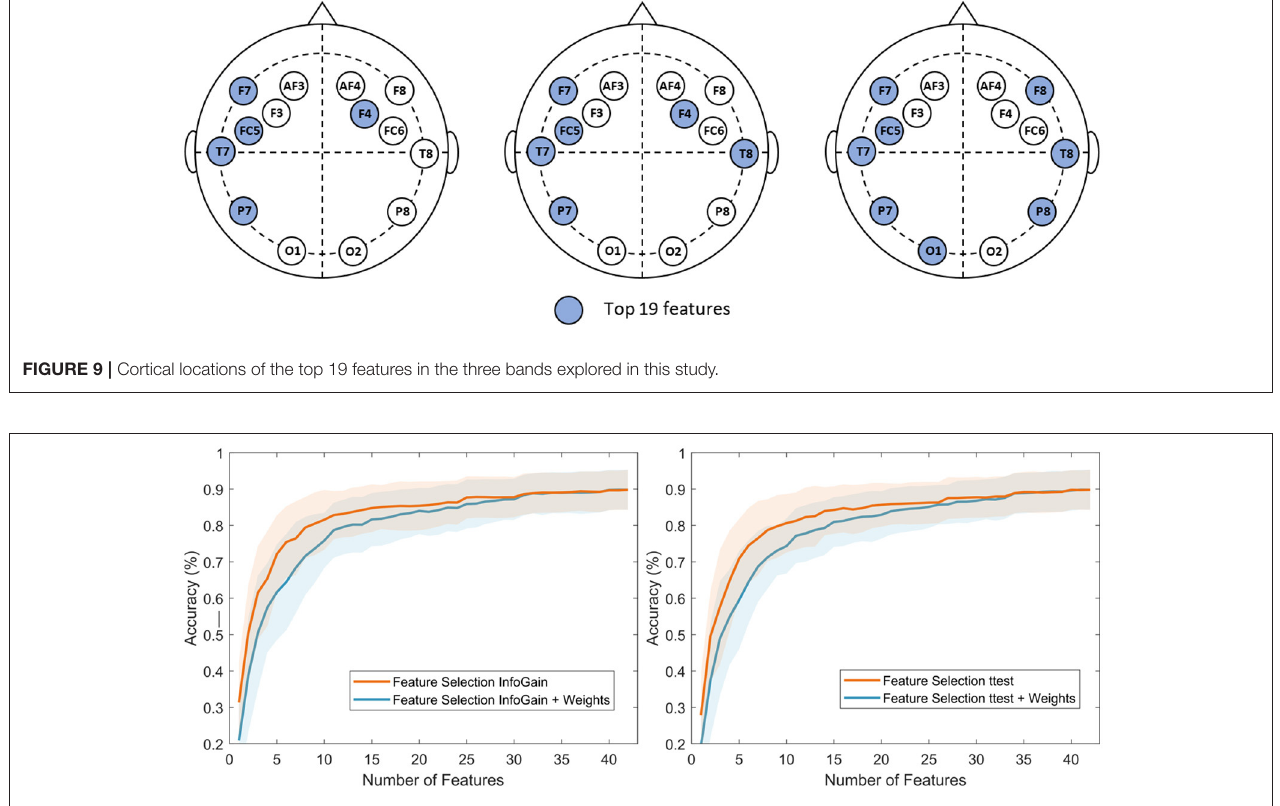
FIGURE 10 | Classification results using Information Gain (left panel) and t -test (right panel)